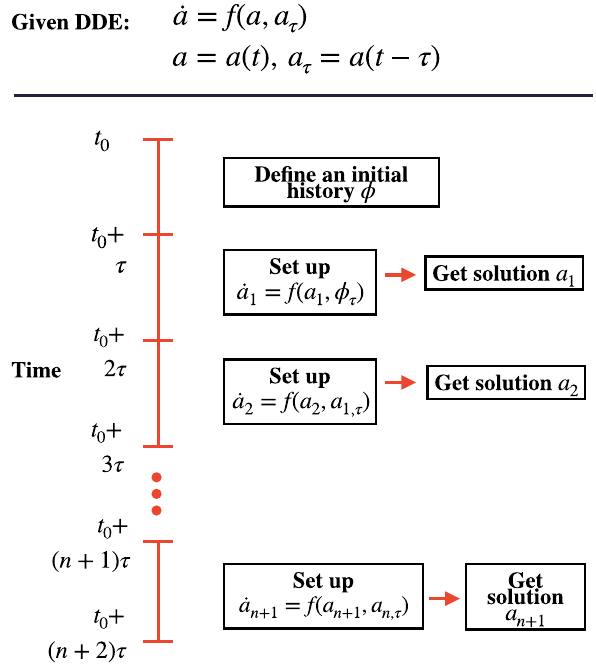
Fig. 1 The method of